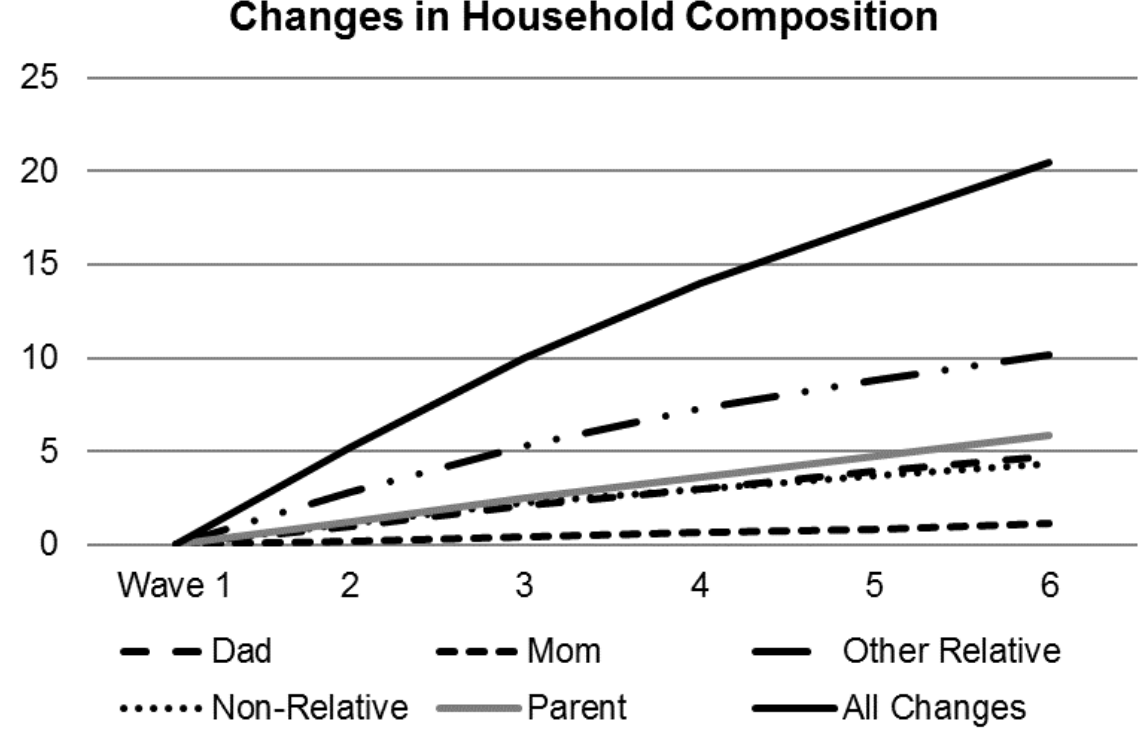
Figure 1: Weighted cumulative percent of children exposed to changes in household composition: pooled 1984 through 2008